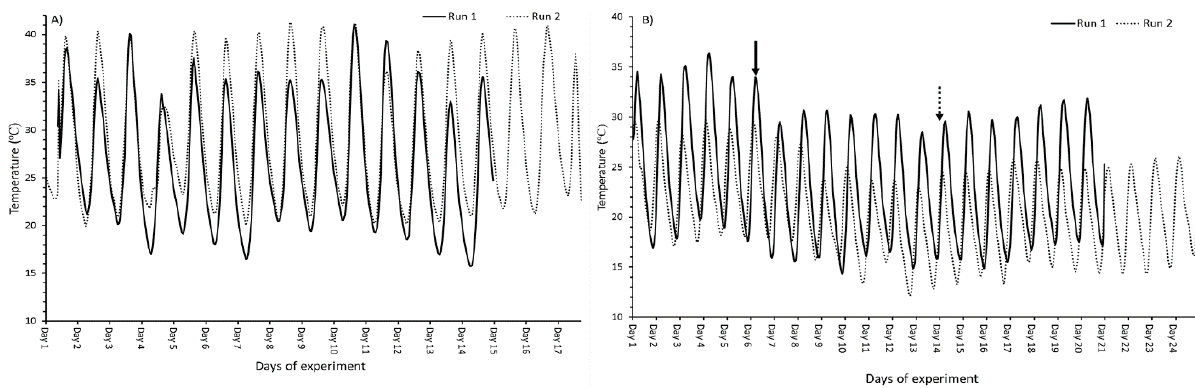
Figure 1. Changes in the water temperature ( ◦ C) during the course of nutrient ( A ) and chemical ( B ) evaluation studies. Run 1 and Run 2 indicate temperature fluctuations per experimental runs. Arrows indicate the time of chemical applications in the first (Run 1) and second (Run 2) run.